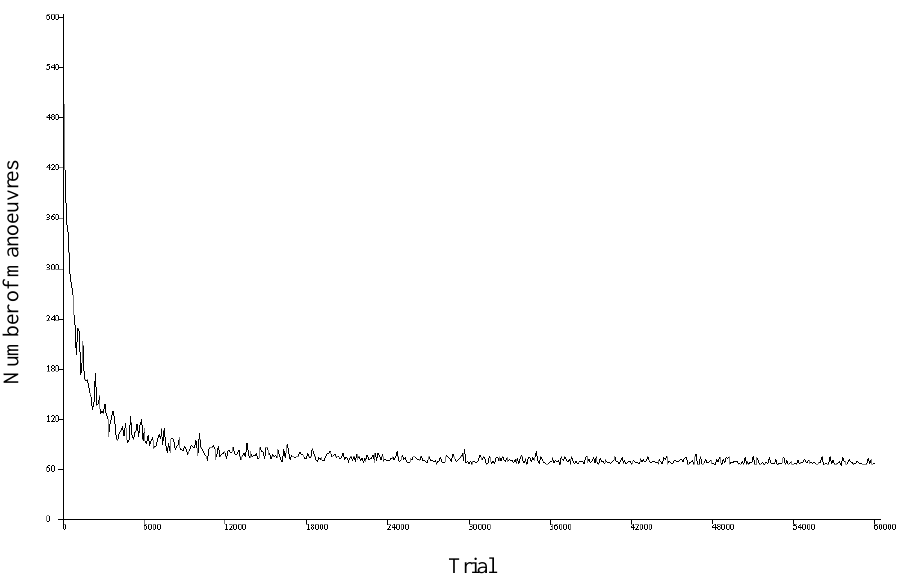
Figure 10. Simulation visualization tool.